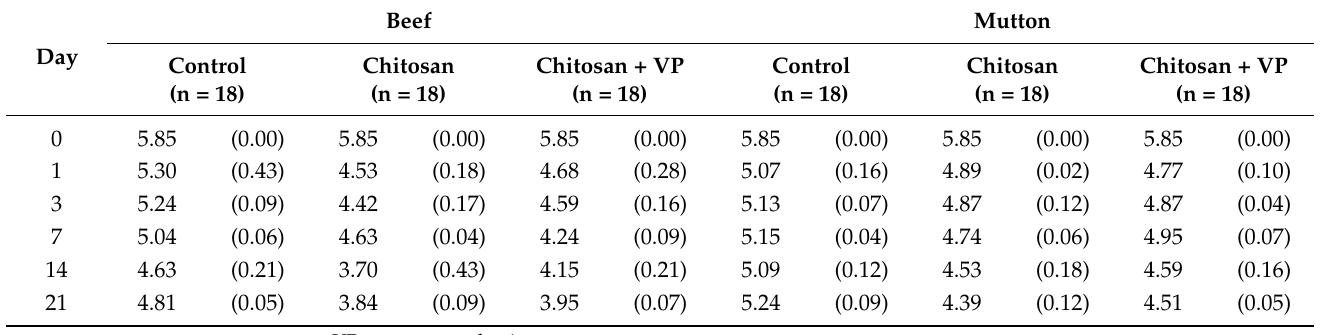
Table 1. S. aureus counts during the storage of beef or mutton under refrigeration for 21 days (average values in bold and standard deviations in italics and parentheses; p ≤ 0.05).